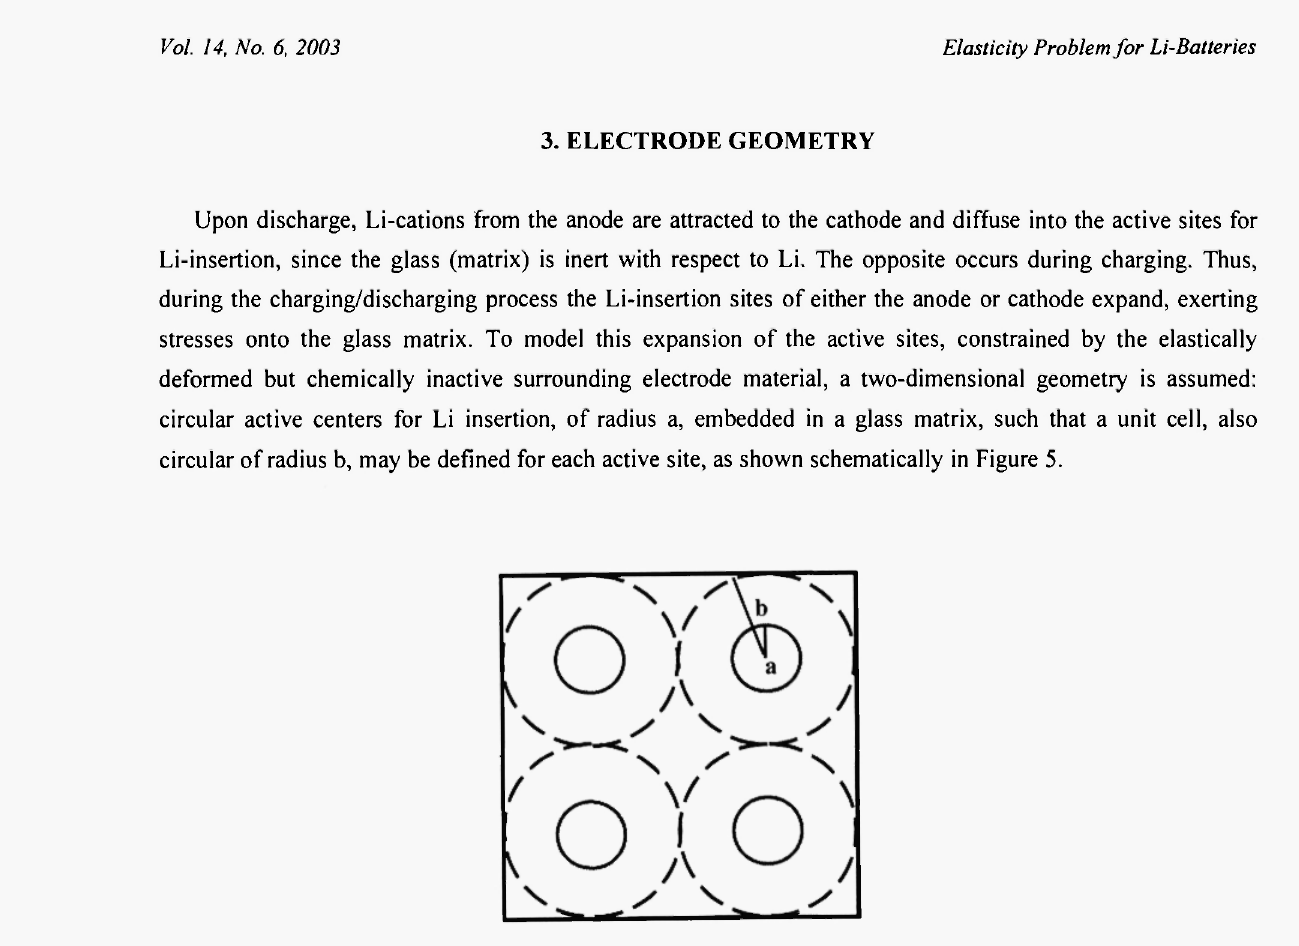
Fig. 5: Idealized geometry of the electrode: Li-insertion particles (of radius a) embedded in a glass matrix. A unit cell is defined by a circle of radius b surrounding a circular particle of radius a (see also Figure